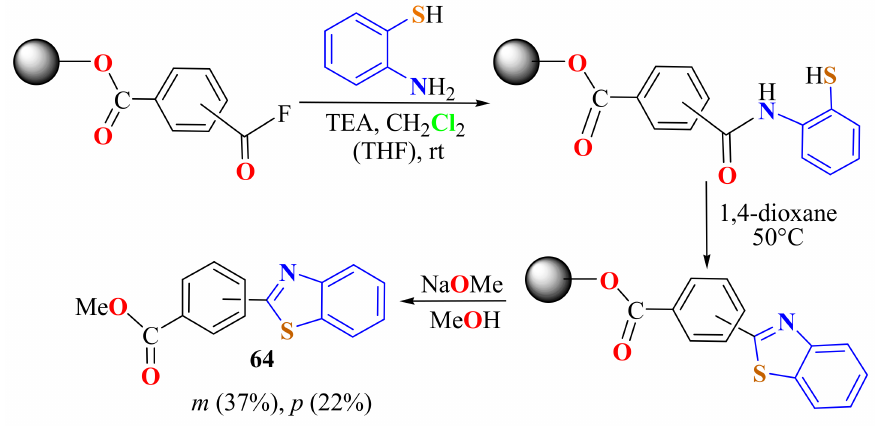
polyethylene glycol methyl ether PEG resin.